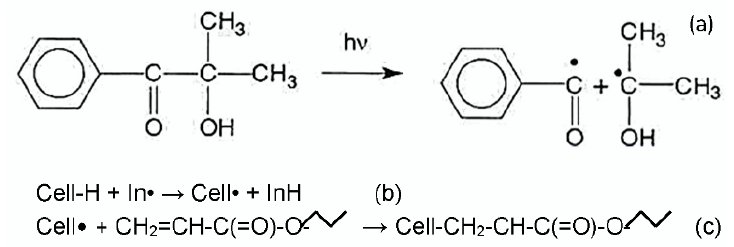
Figure 1. UV grafting mechanism: ( a ) Photoinitiator (Darocur 1173) fragmentation; ( b ) H abstraction from cellulose backbone; ( c ) grafting of acrylic oligomer on cellulose.